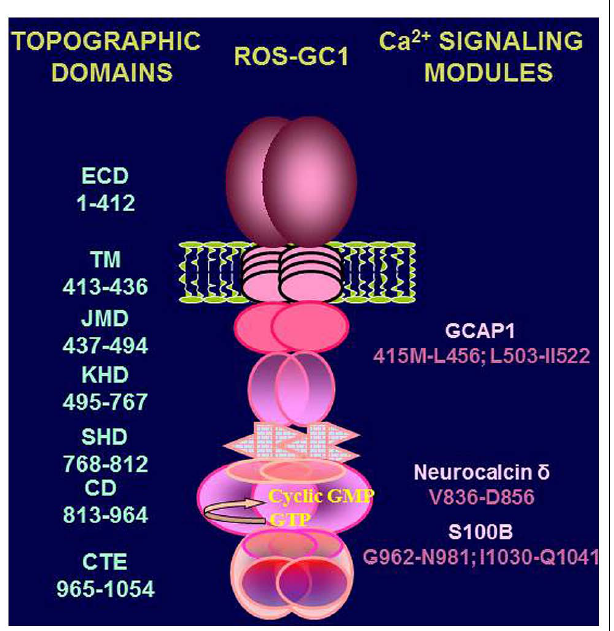
FIGURE 7 |Topography of ROS-GC1. A schematic diagram of ROS-GC1, with its multiple domains is provided.The extracellular (ECD), the transmembrane (TM), the juxtamembrane (JMD), the kinase homology (KHD), the signalling helix (SHD), the catalytic (CD), and the C-terminal extension (CTE) domains have been identified on the left-hand side; the GCAP1, NC δ , and S100B binding domains are indicated to the